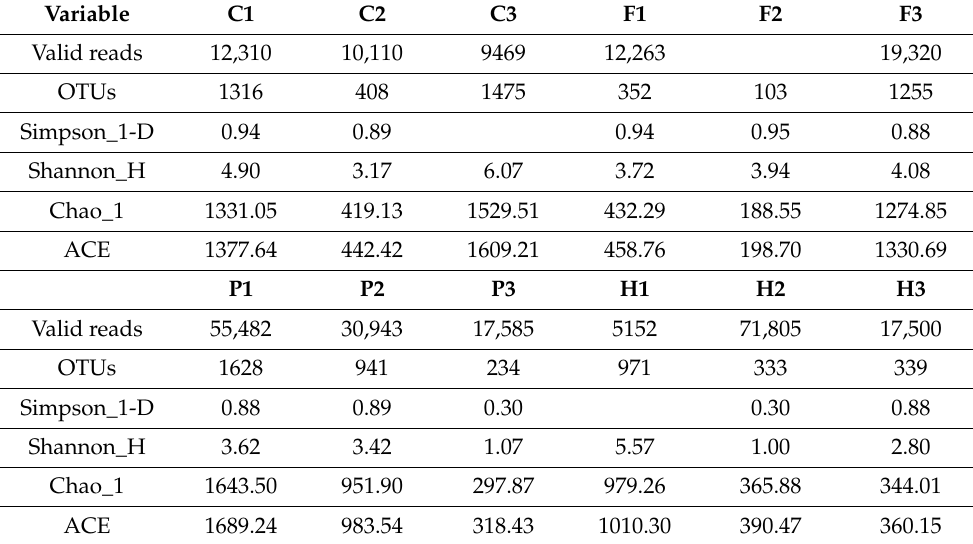
Table 3. Estimated OTU Richness and Diversity Indices of the Animal Manure Samples Collected from different sources around Johannesburg, South